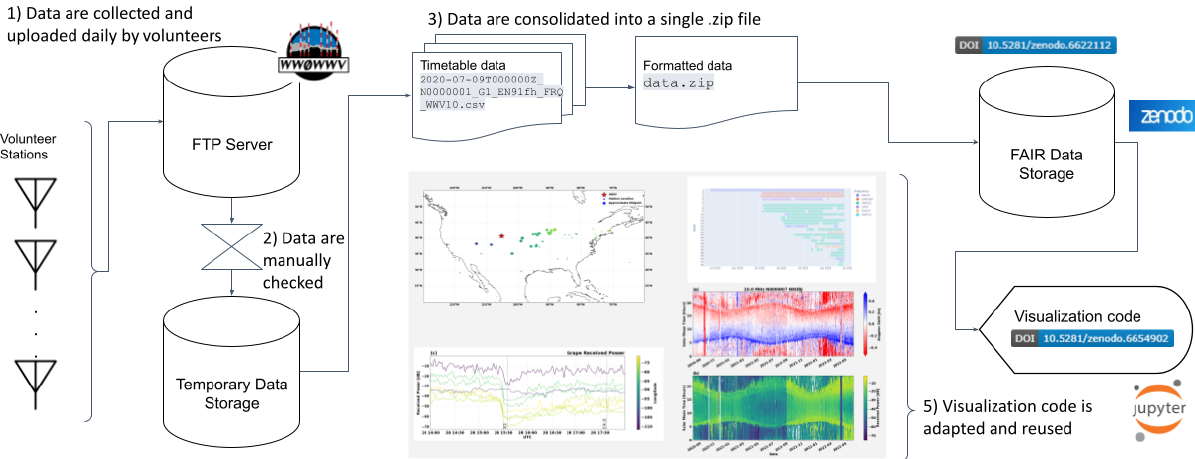
Figure 2. A graphical abstract showing how the data are collected, as described in Sect. 3.2. The visualization figures are rendered at full scale elsewhere in this paper.